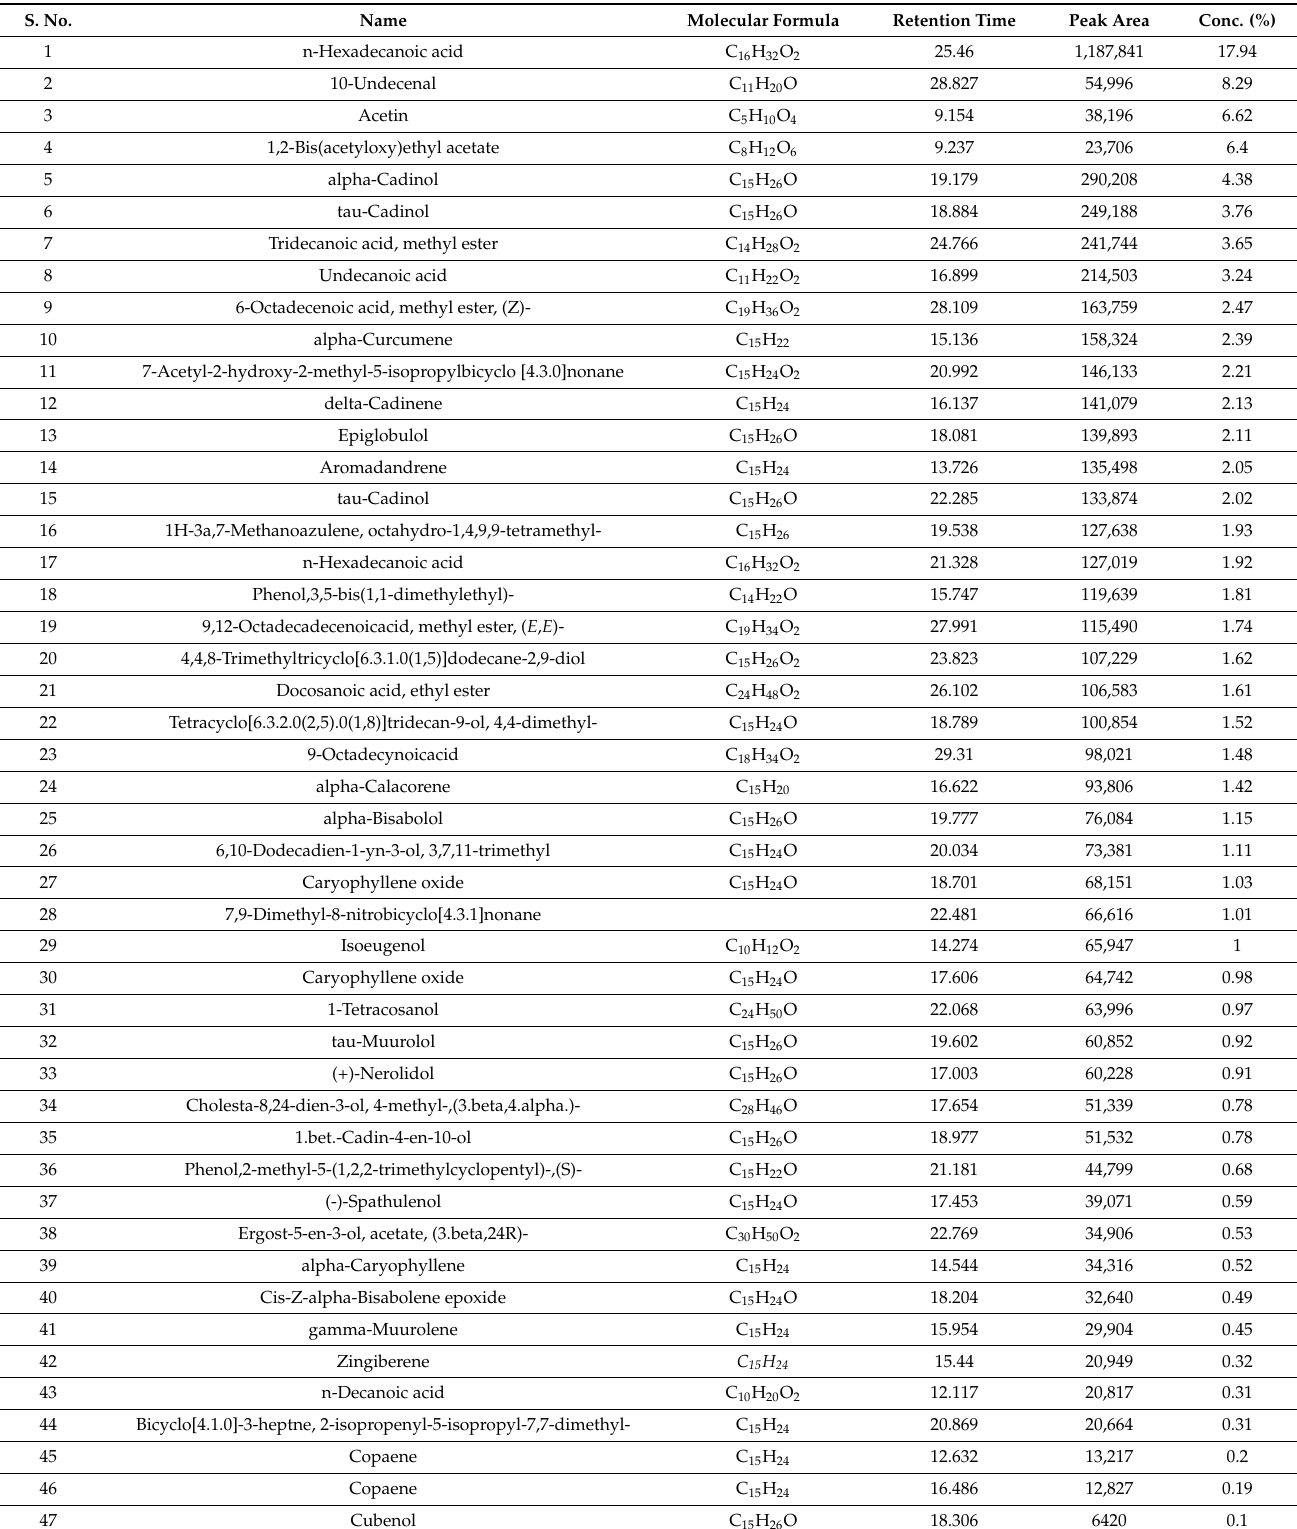
Table 1. GC-MS analysis of the ethyl acetate fraction of C. macrophylla